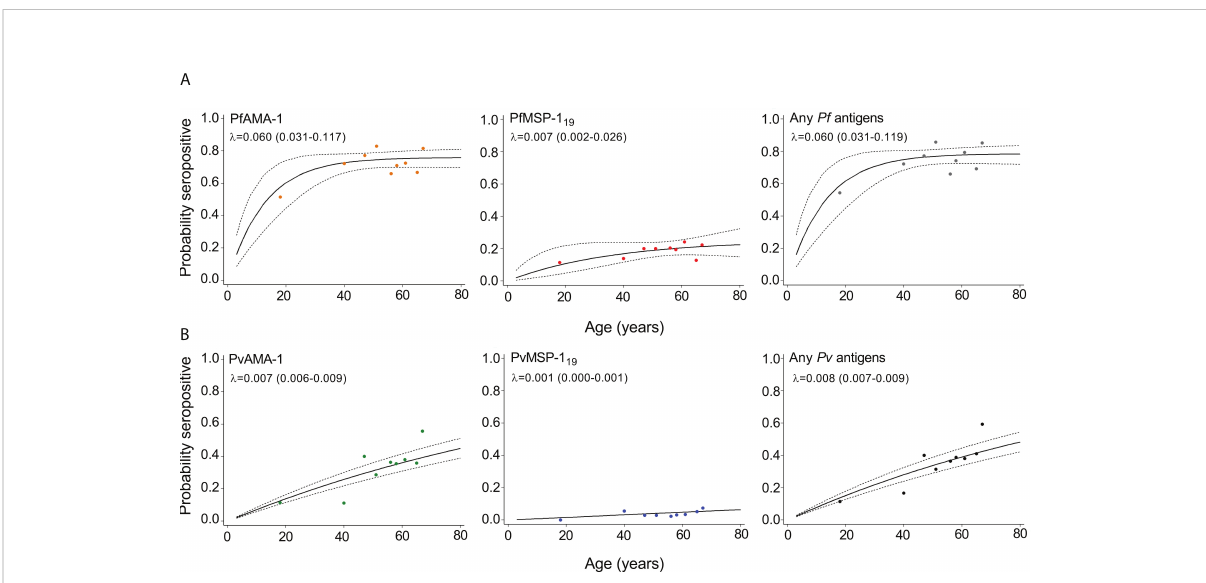
FIGURE 3 Annual probability of malaria seroconversion rate in Mukdahan Province. (A) P. falciparum – speci fi c antigens and (B) P. vivax – speci fi c antigens by age in each setting. Points indicated observed seroprevalence, and solid lines show model-predicted seroprevalence. Broken lines represent 95% con fi dence intervals. Seroconversion rates (SCR; l ) are presented on the